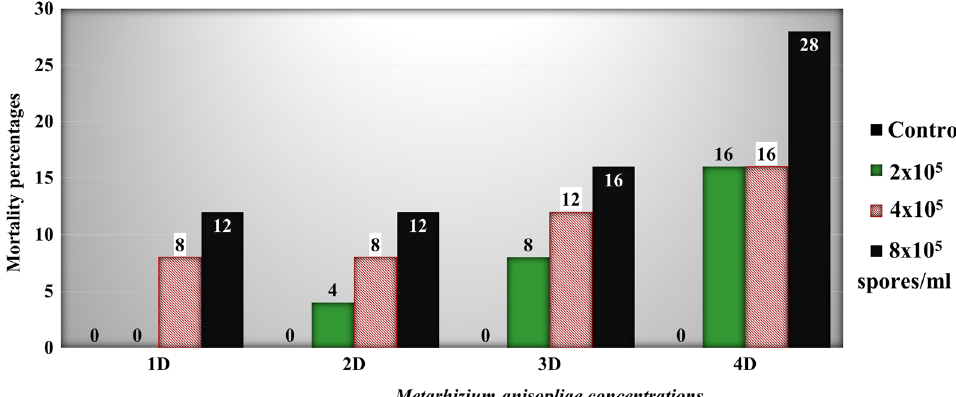
Fig. 1 Daily mortality of 5th instar Agrotis ipsilon larvae by different concentrations of Metarhizium anisopliae . Values represent the mean of 6 replicates each of 4 larvae